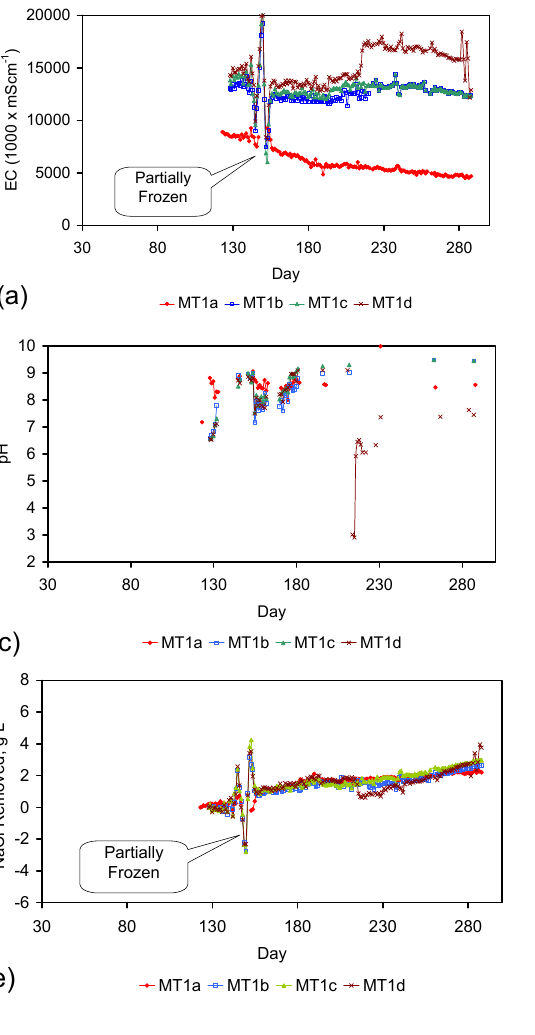
Figure C13. ( a ) EC vs. day; ( b ) Eh vs. day; ( c ) pH vs. day; ( d ) pH vs. Eh; ( e ) NaCl Removed